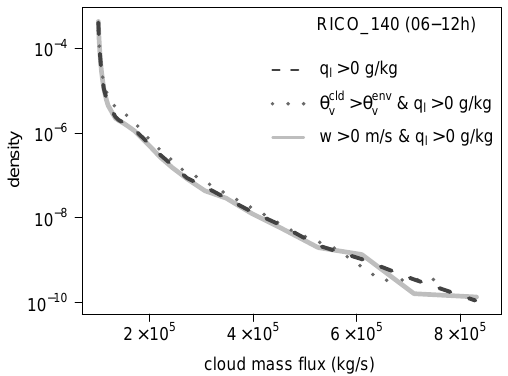
Figure 2. Semi-logarithmic plot of the cloud rate probability den- sity function of cloud-base mass flux for the different cloudy point definitions (1–3). This plot corresponds to the RICO-140 simulation time frame of